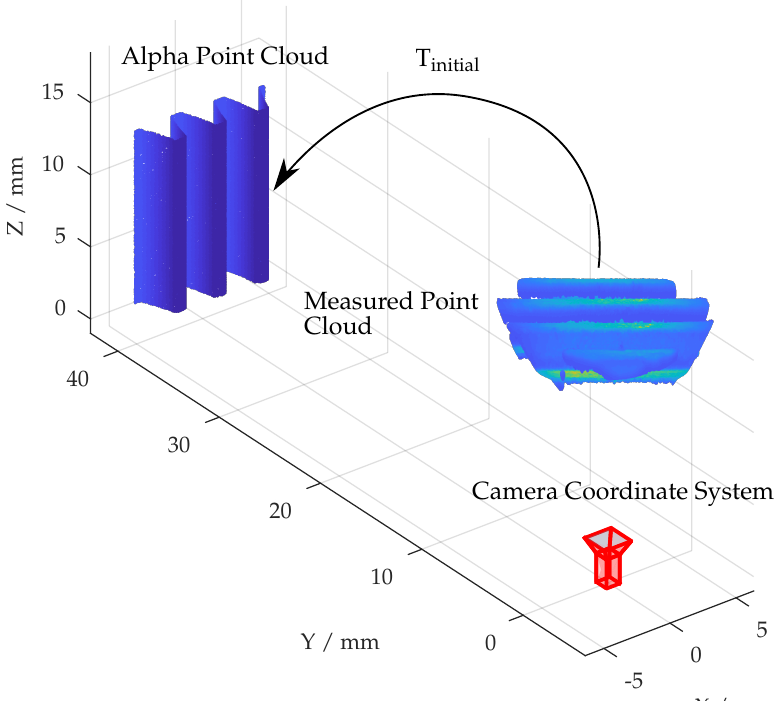
Figure 10. Initial transformation from camera coordinate system with respect to the alpha point